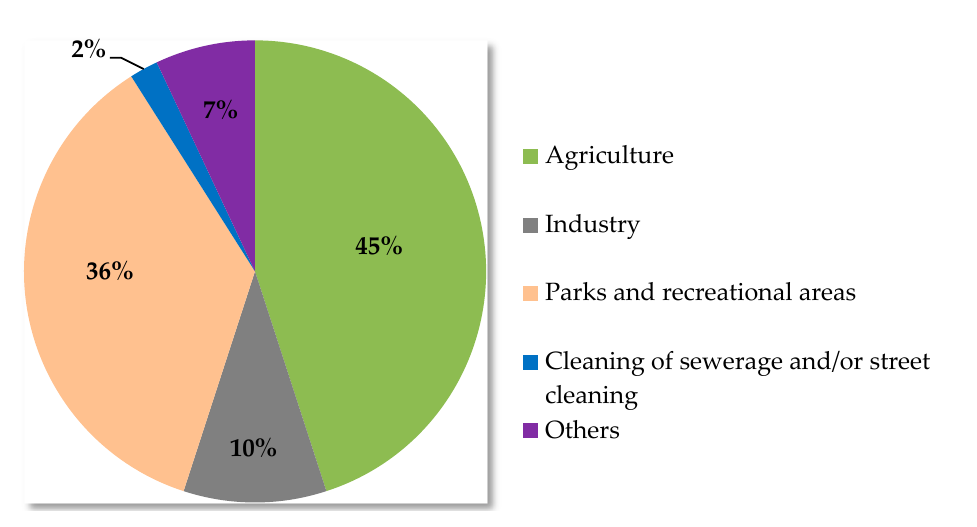
Figure 4. Uses of reclaimed waters in Spain (%) considering a total volume of 268 hm 3 / year. Source: elaborated with information from [41,42].